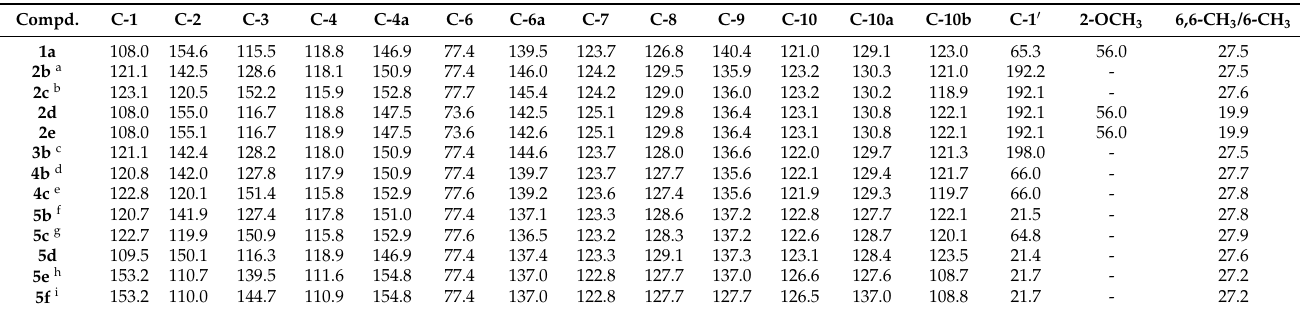
Table 3. 13 C NMR chemical shifts (in ppm) for compounds of series 1 to 5 determined at 100 MHz in CDCl 3 . The assignments were made with 2D NMR spectroscopy, COSY, HMQC and HMBC experiments.